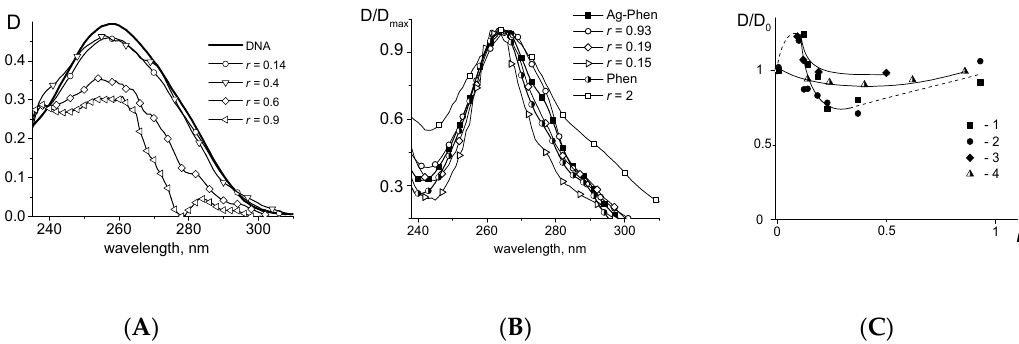
Figure 2. Calculated absorption spectra of DNA ( A ); and normalized spectra of Ag–Phen ( B ) in complexes at different r ( r values are given near lines). Spectra of free Ag–Phen and Phen are also presented. Dependences of relative change in Ag–Phen (1, 2) and Phen (3) absorption at 265 nm (1, 3) and 277 nm (2) in complexes with DNA and relative change in DNA absorption at 260 nm in complexes with Ag + (4) on r value are shown in ( C ). D 0 is an adsorption at r = 0.